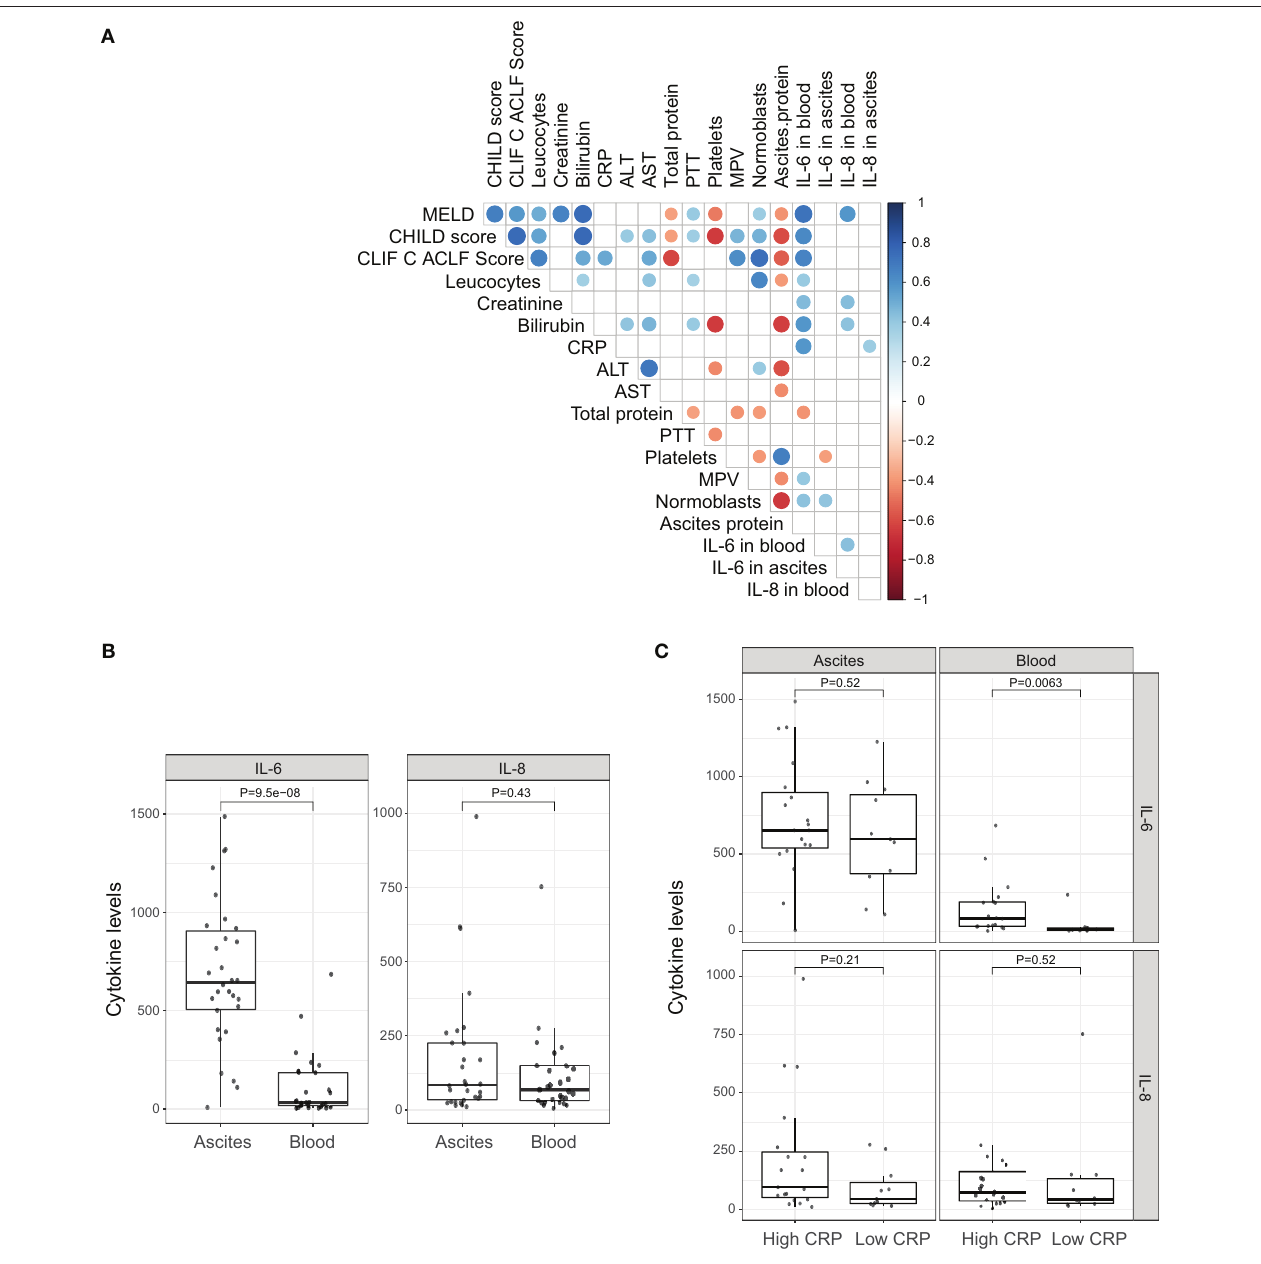
FIGURE 1 | Pro-inflammatory cytokines. (A) Correlation of clinical markers for disease progression and systemic inflammation with cytokines IL-6 and IL-8 in blood and ascites. (B) Comparison between cytokines levels in ascites and peripheral blood. (C) Comparison between cytokines levels in ascites and peripheral blood under different systemic inflammation status (low CRP profile vs. high CRP